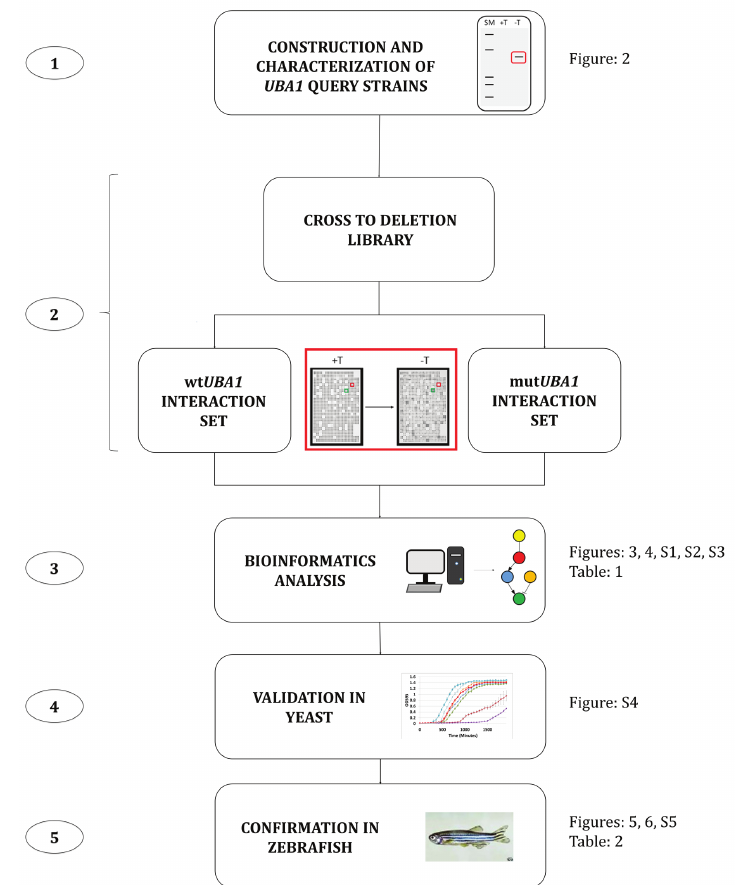
Figure 1. YANA analysis of UBA1 genes. Numbers illustrate various steps in our analysis. (1) Construction of query strains by integrating wildtype and mutant variants of the UBA1 gene into pombe . (2) Crossing the query strains (mutant or wildtype) to a complete non-essential deletion collection. (3) Bioinformatic analysis to generate the top ‘gene hits’. (4) Validation of the top hits in yeast. (5) Confirmation of the top hits in zebrafish. presence and absence of thiamine (final concentration, 15